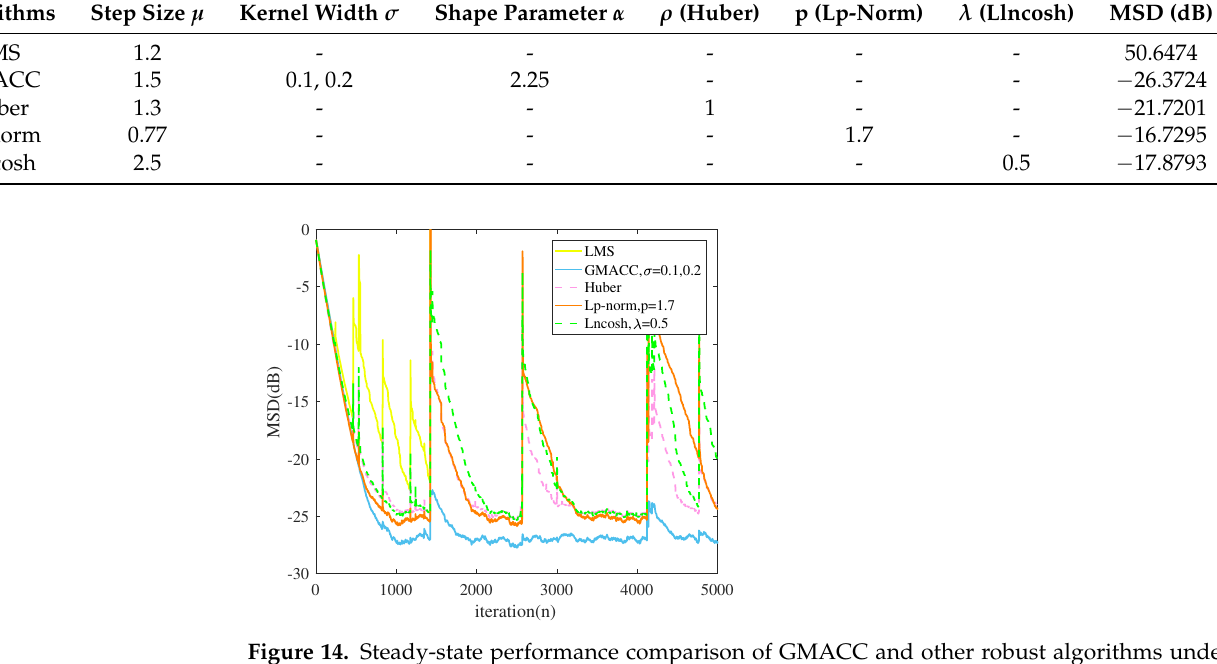
Figure 14. Steady-state performance comparison of GMACC and other robust algorithms under asymmetric and non-Gaussian distribution